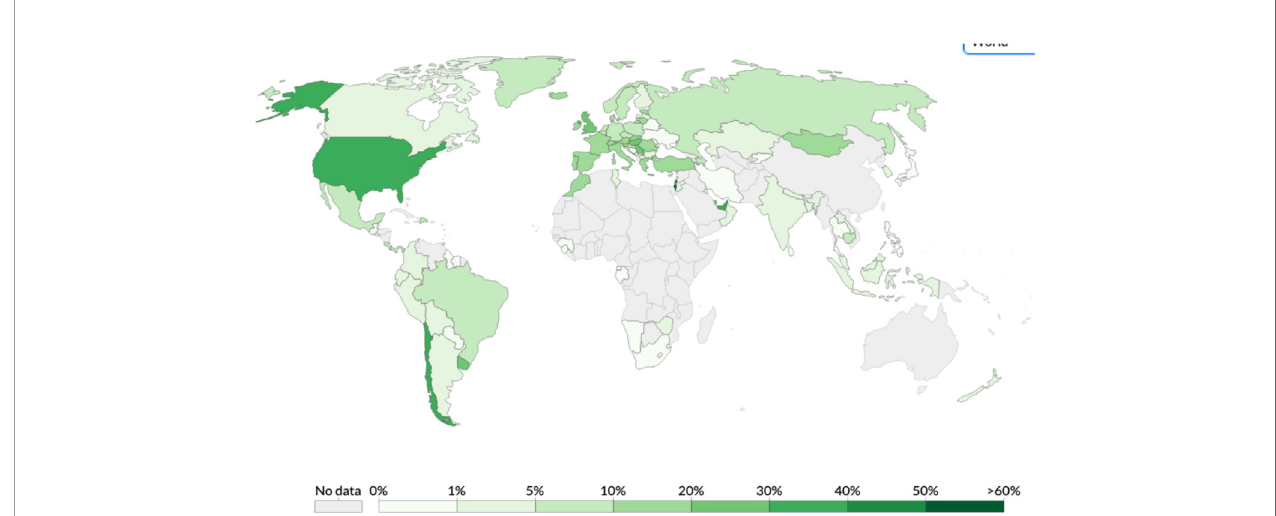
FIGURE 7 | Share of the population fully vaccinated (have received all doses prescribed by the vaccination protocol) against COVID-19, May 10, 2021. Retrieved from: ‘ https://covid-nma.com/dataviz/ ’ [Online